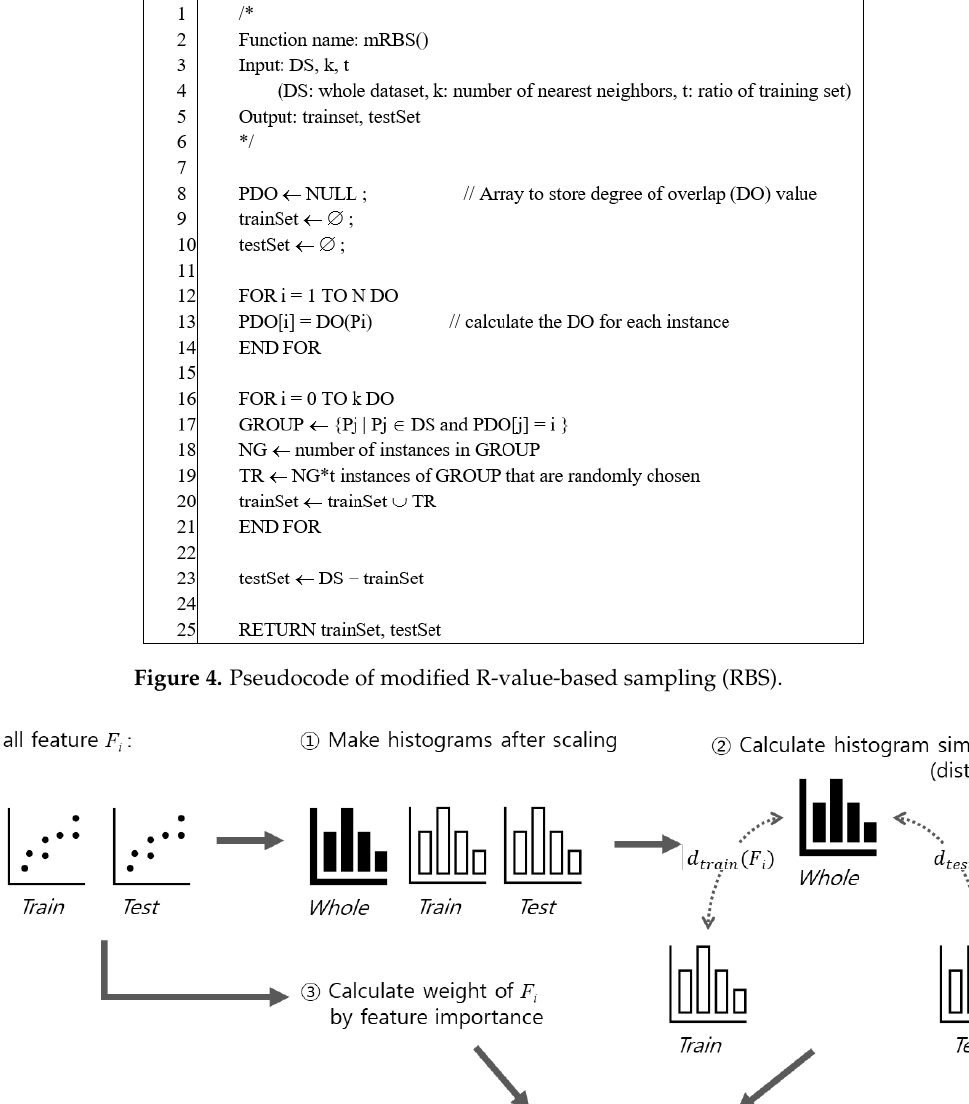
Figure 5. The measurement of similarity between original dataset and given train/test